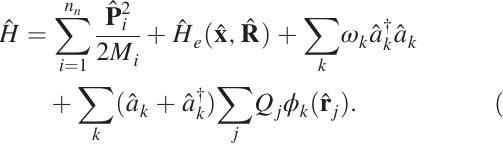
ffiffiffiffiffiffiffiffiffiffiffiffiffiffiffiffiffiffi 4 π =V